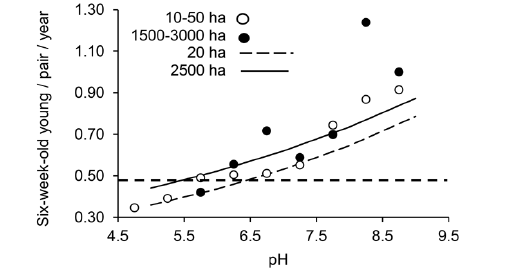
Fig. 5 . Reproductive success of Common Loons ( Gavia immer ) across southern Canada as a function of lake area and pH between 1992 and 2010. Shown are model-averaged predictions from the third best model from the second part of the analysis (Table 3), with log lake area held at two selected values and year held at its median value. Means are shown across each of several arbitrary bin classes (dots) for two different lake size categories to illustrate model fit, but be aware that these means were not the data used to fit the model. The horizontal dashed line is the minimum estimated number of six-week-old young per pair per year (0.48) required to offset adult and juvenile mortality (Evers